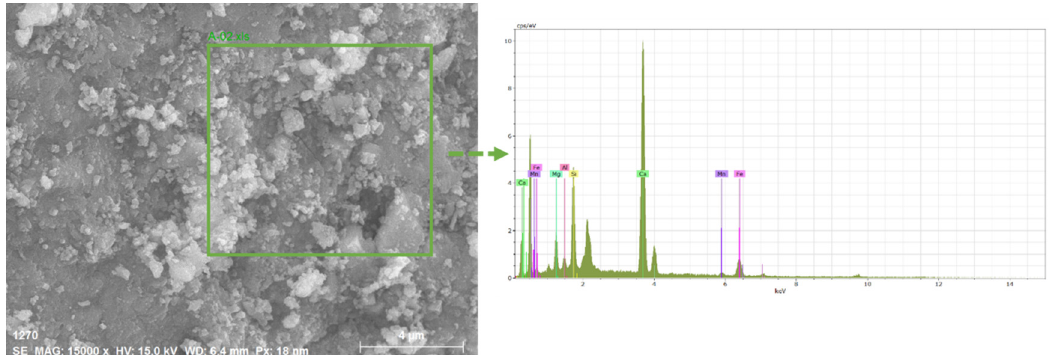
Figure 2. SEM–electron dispersive X-ray spectroscopy (EDS) analysis results of the steel slag specimen.